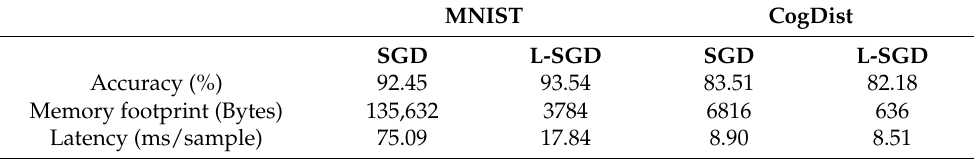
Table 6. L-SGD (float-32) vs. SGD